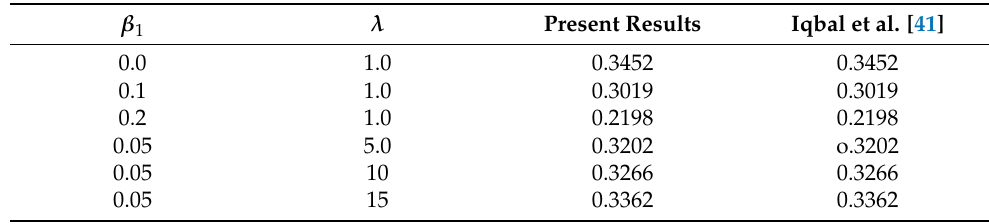
Table 5. A comparison of the present results of C f against β and λ with those of Iqbal et al. [41]